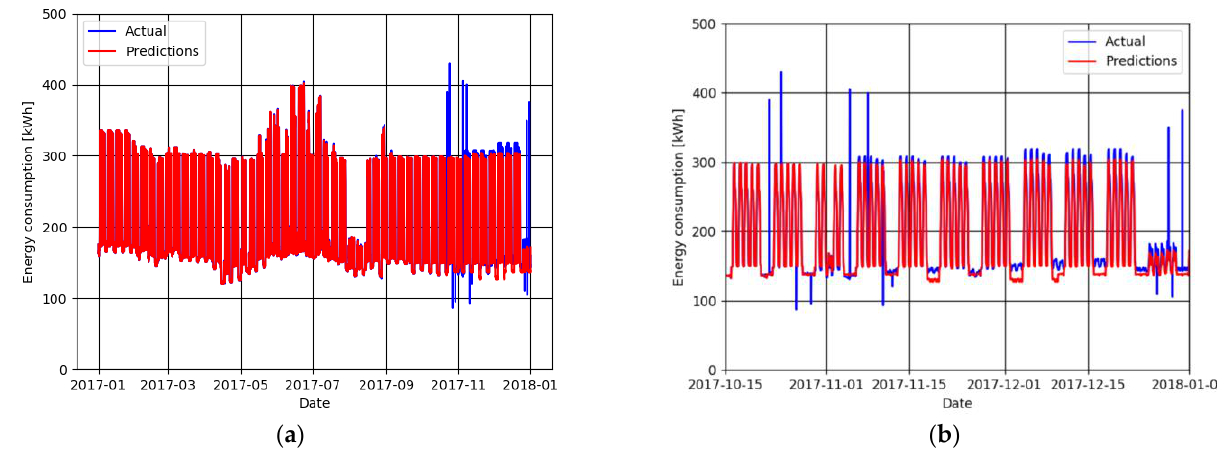
Figure 5. Regression results using the random forest algorithm on adapted data: ( a ) regression results and actual data during the whole year and ( b ) regression results and actual data during the period complementary to the training phase. Table 2. Performance of the regression methods on the adapted data.